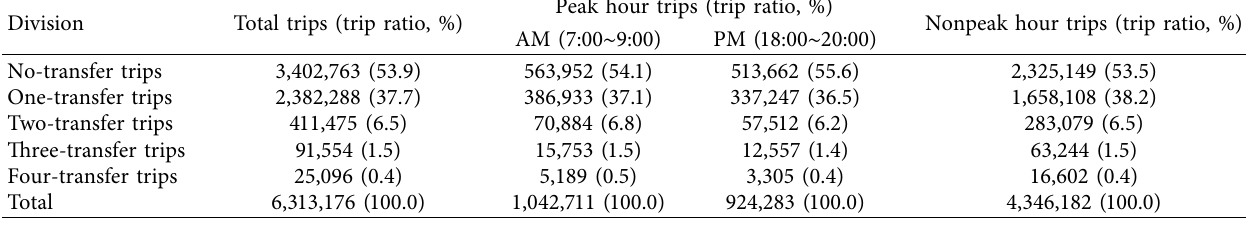
Table 6: Results of travel route estimation for urban subway network in Seoul.